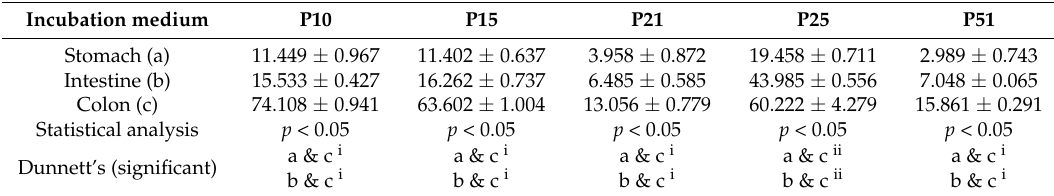
Figure 8. Thiol concentration in simulated colon condition for polymer ( a ) P10, ( b ) P15, ( c ) P21, ( d ) P25, and ( e ) P51. Table 4. Final thiol concentration (×10 − 6 M) of each simulated condition, mean ± SD, n = 3.